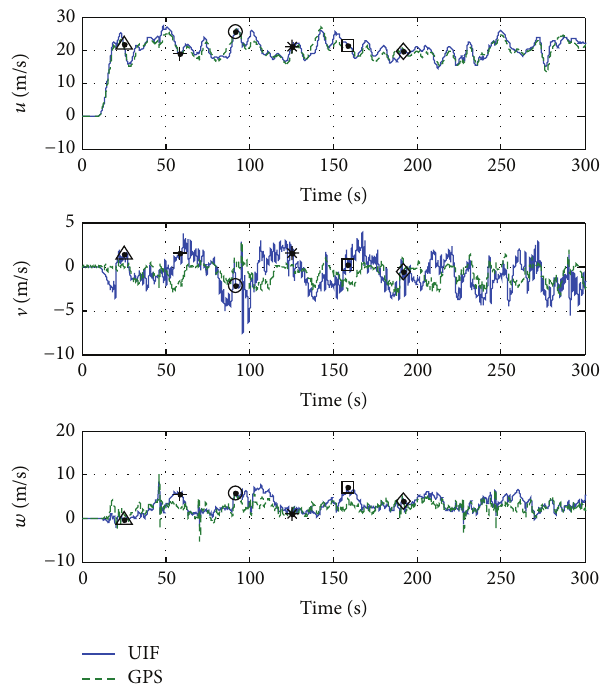
Figure 6: Estimated velocity components for Flight